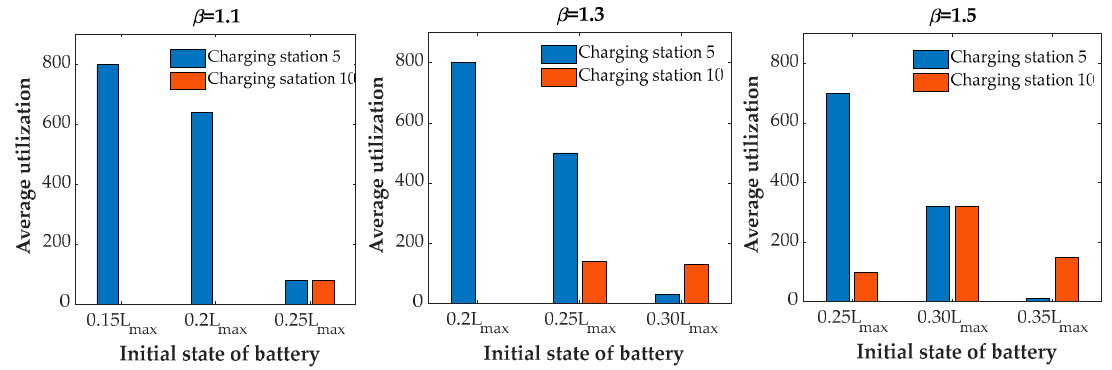
Figure 3. Charging station utilizations. Energies 2020 , 13 , x FOR PEER REVIEW